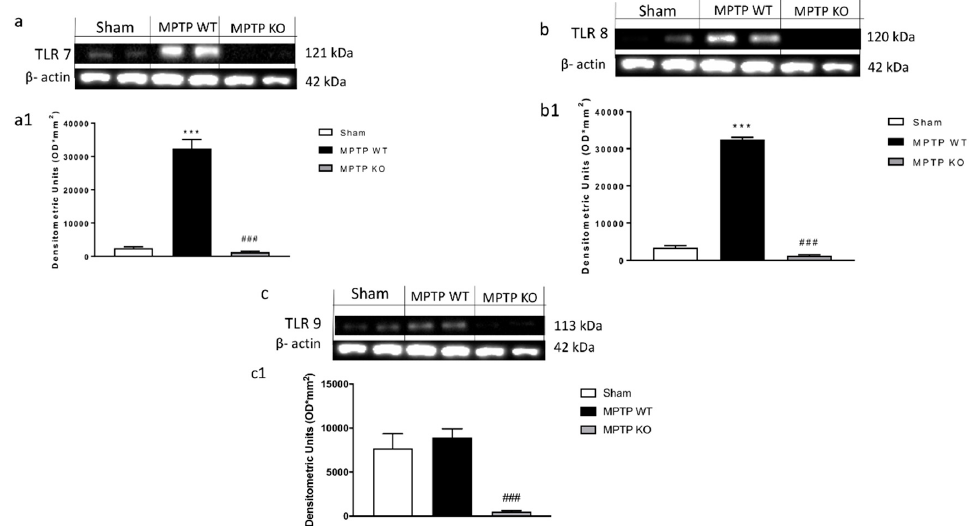
Figure 1. Evaluation of Toll-like receptors (TLR) 7, 8, and 9 in Parkinson’s disease (PD). Using Western